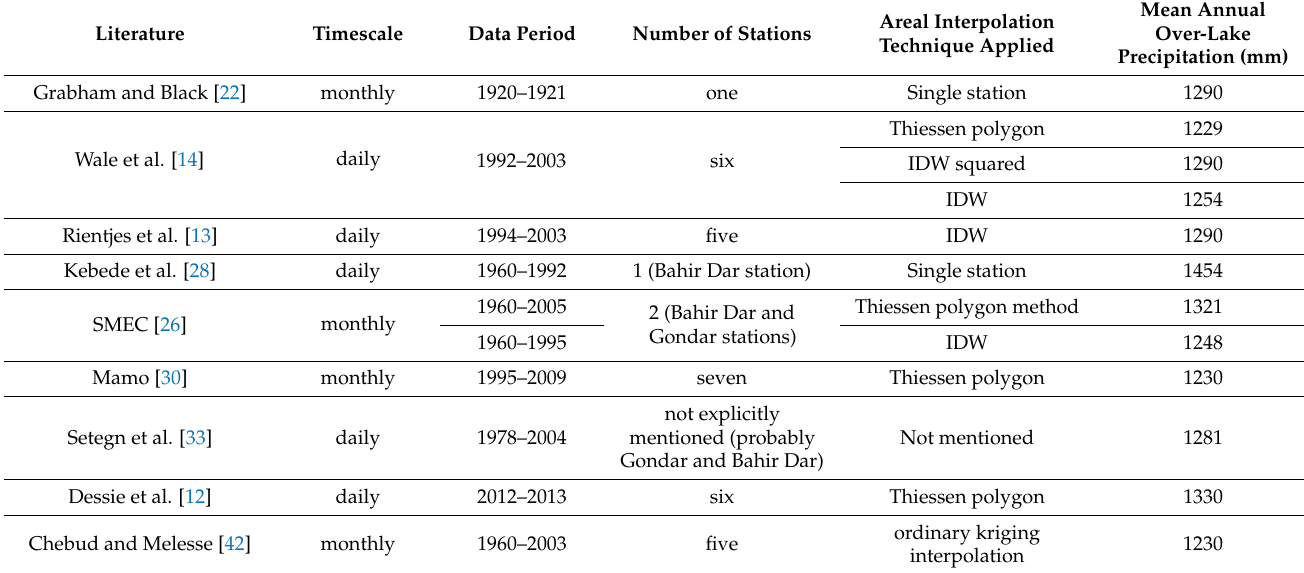
Table 1. The mean over-lake precipitation estimations made by different authors (applying different methods) for the different periods and time